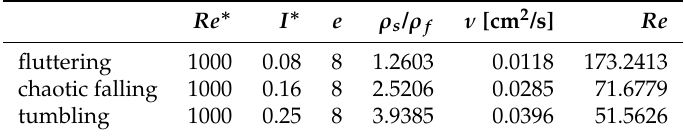
Table 2. Physical parameters employed for three falling patterns of ellipse.